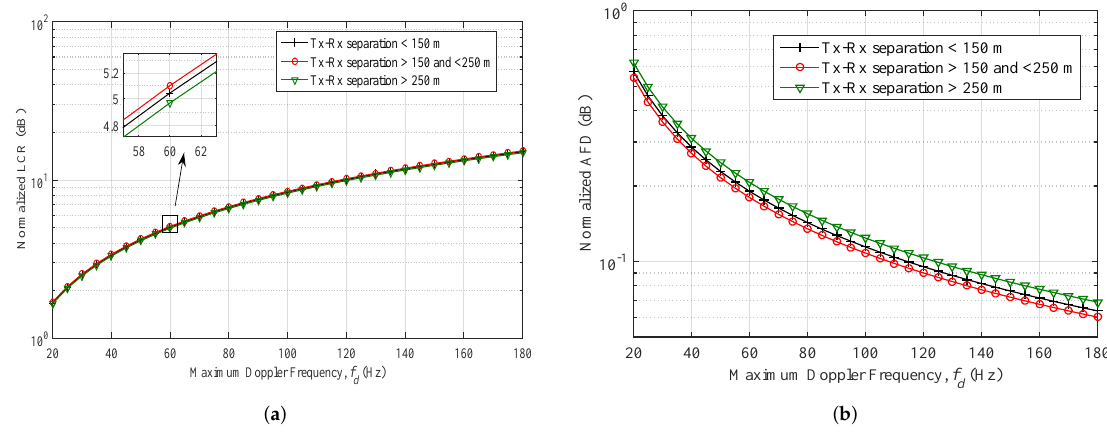
Figure 4. Level-crossing-rate (LCR) and average fade duration (AFD) plotted against different values of maximum Doppler shift in ( a , b ), respectively; for different scenarios of outdoor mmWave (case 1; 38 GHz) radio propagation environments. ( m = 1, ρ = 2).